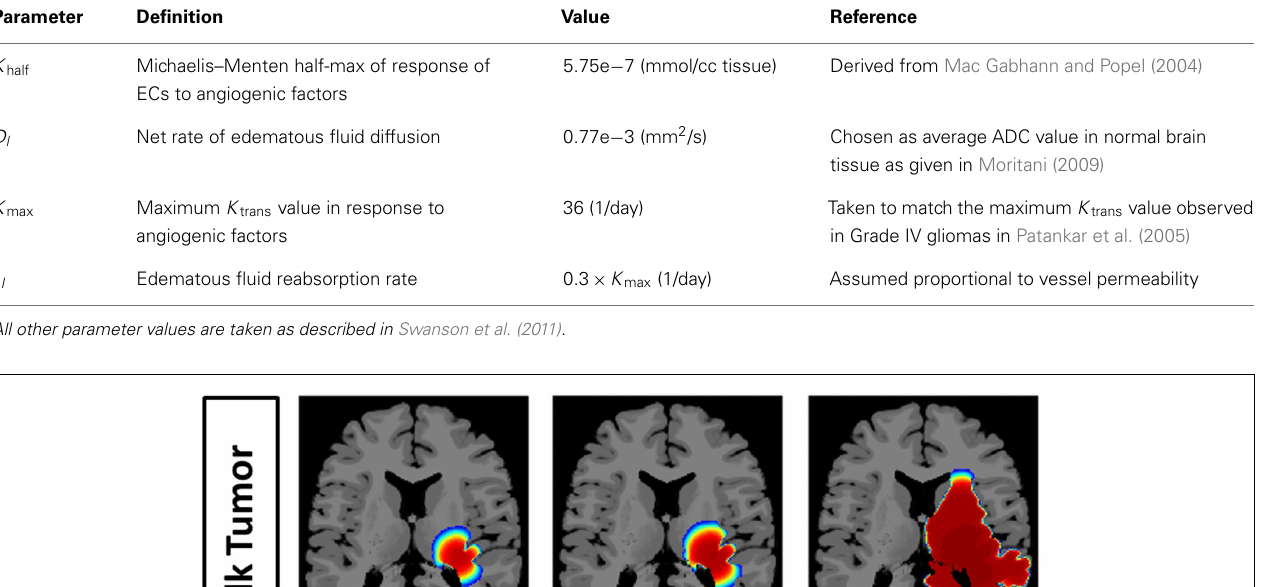
spherically symmetric equivalent radial growth of the regions containing tumor cells above a threshold and edematous fluid above a threshold. In the untreated context, these lines are nearly